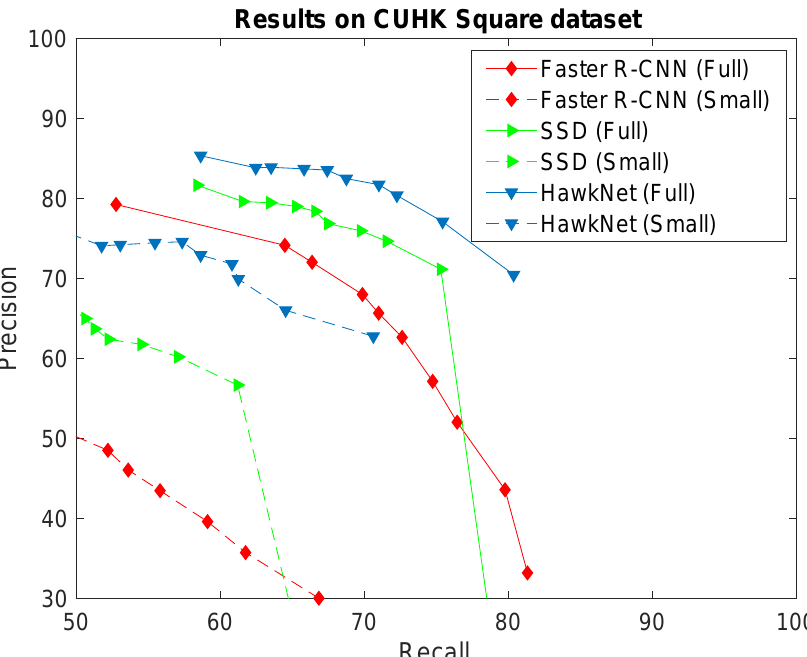
Figure 8. Comparison between the results achieved by our T-RexNet, SSD and Faster-RCNN in the civilian surveillance test case using the CUHK square dataset. Full and Small indicate whether the test has been conducted over the whole image or the upper half only, where perspective makes people much smaller and the gap between our approach and others is even more